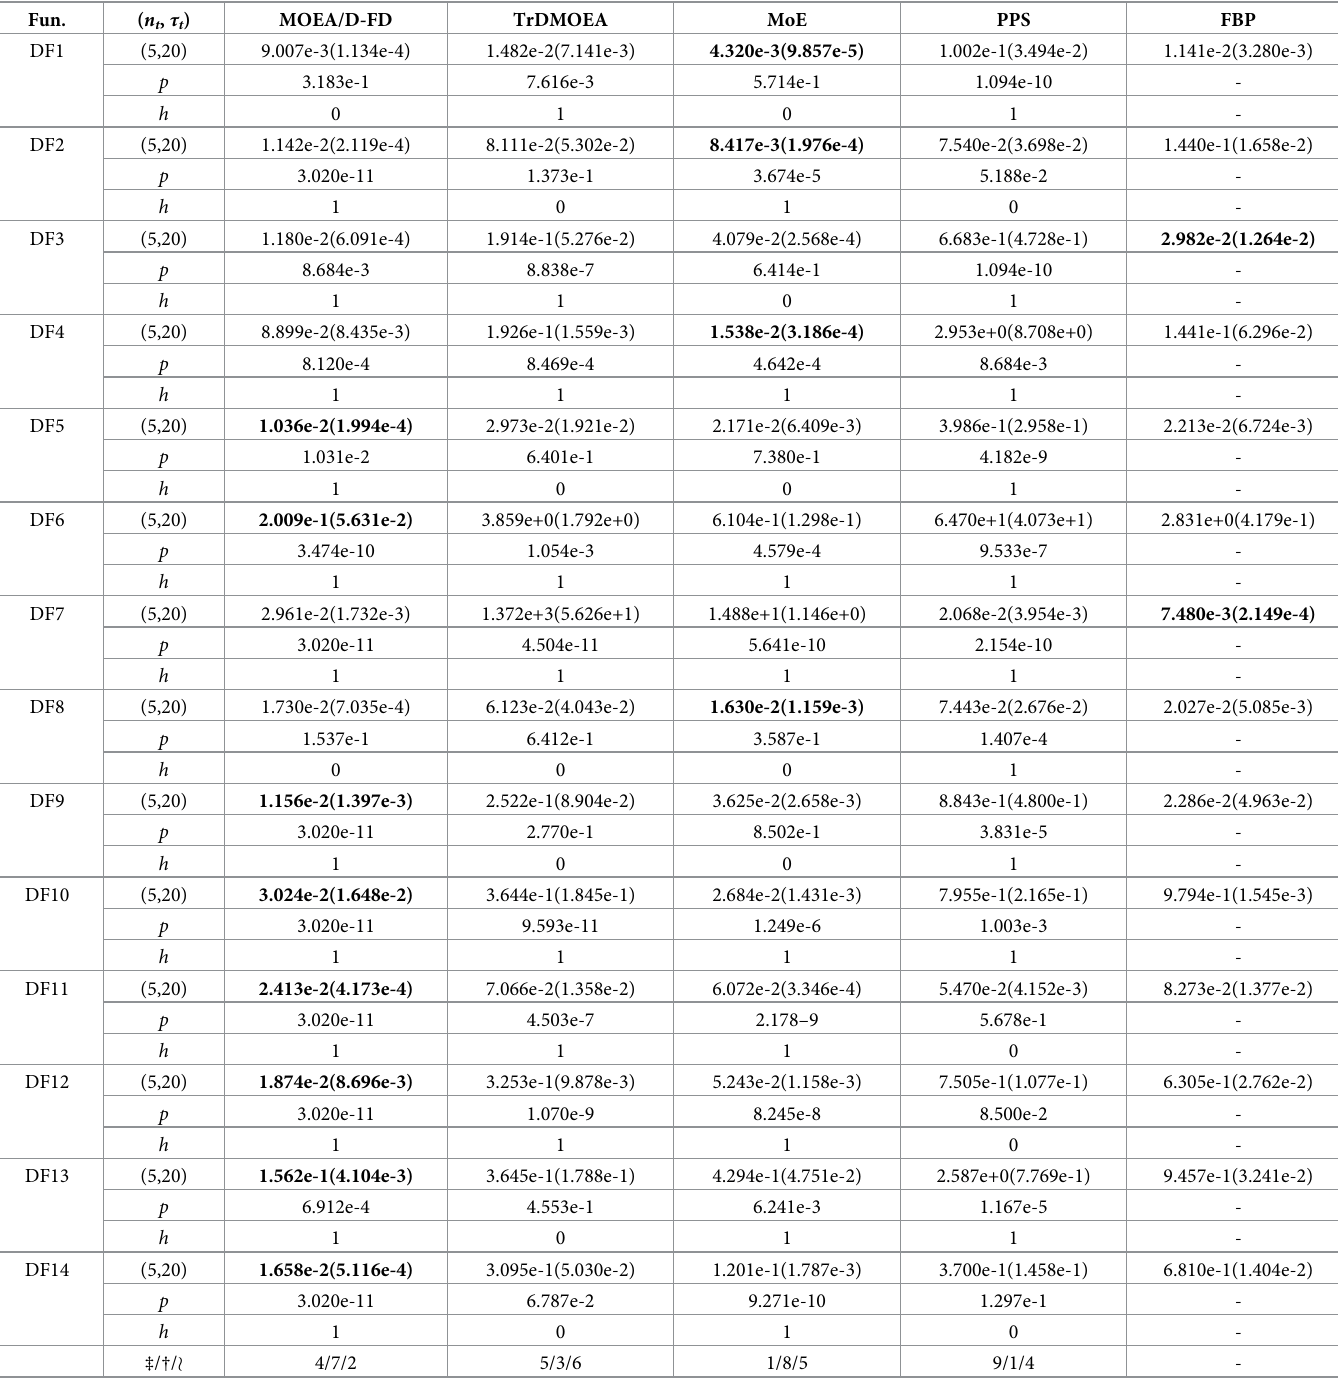
Table 7. Mean and standard deviation values of MSP obtained by five algorithms for ( n t , τ t ) = (5,20).